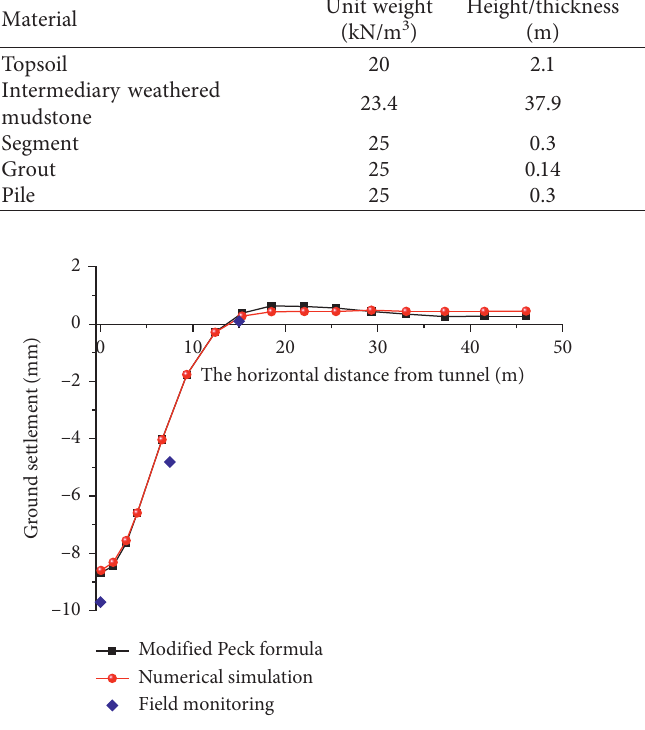
Figure 7: The ground settlement trough curve.